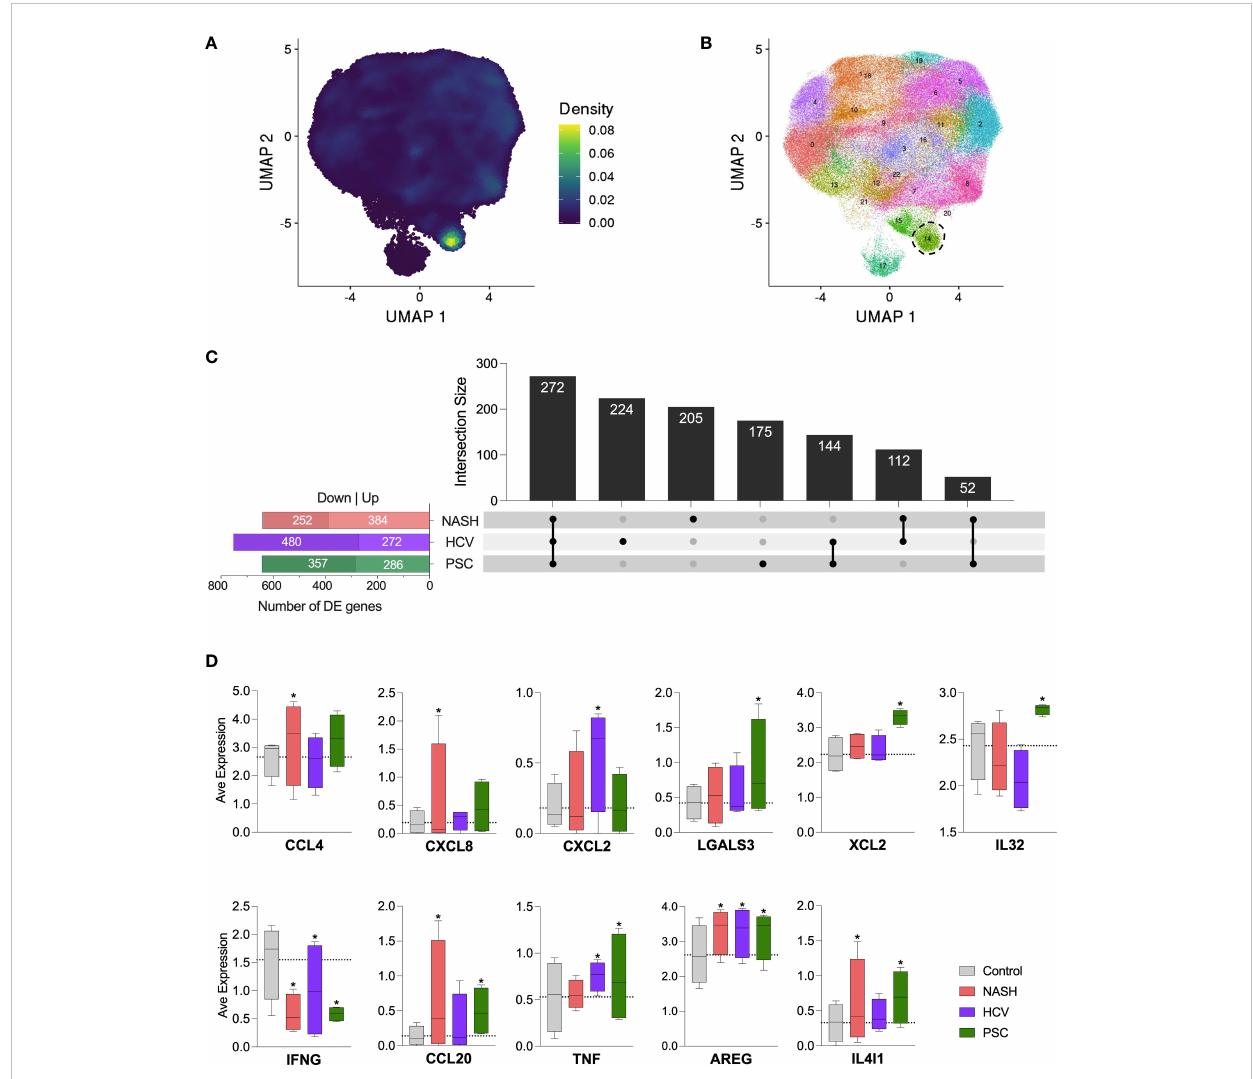
FIGURE 8 Detection of innate lymphoid-like cells (ILC-like) among hepatic NK cells in cirrhotic livers. (A) UMPA showing the ILC transcriptomic signature density among the cell clusters. (B) Increase of clustering analysis resolution showed that subset C6 subdivided into two clusters. Cluster surrounded by dot lines indicate ILC-like cells. (C) Differentially expressed genes identi fi ed in the ILC-like cluster and their intersections. (D) Average normalized expression of DE genes with immunological signi fi cance. * Signi fi cant difference compared to control cells according to DEG